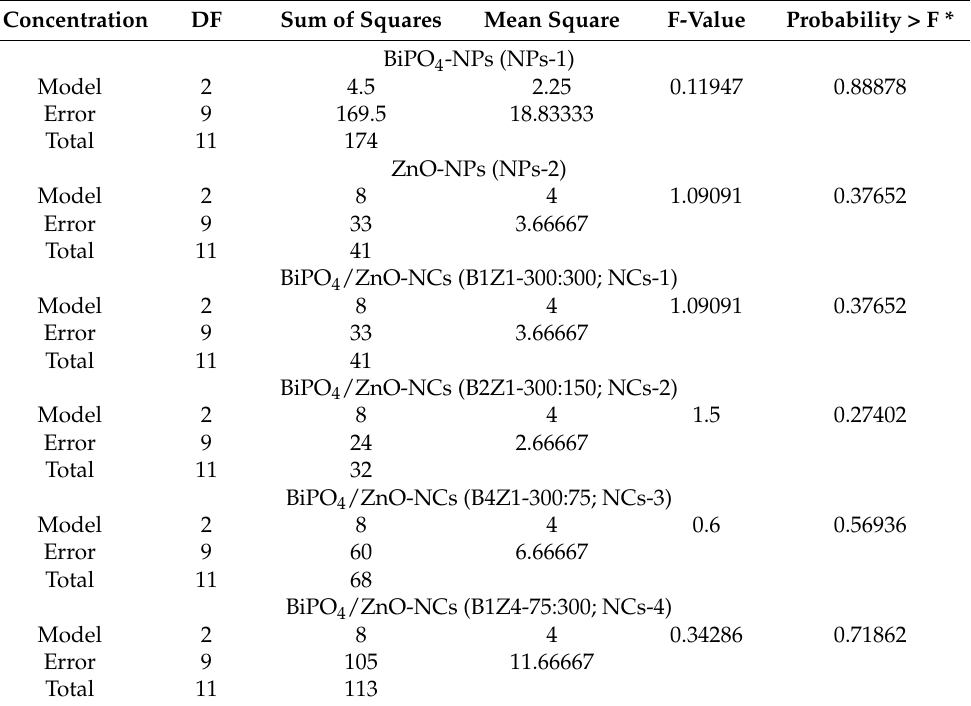
Table 1. ANOVA in vitro antibacterial susceptibility testing performed with as-synthesized NPs and NCs at different concentrations (20, 40, 60, and 80 µ g mL − 1